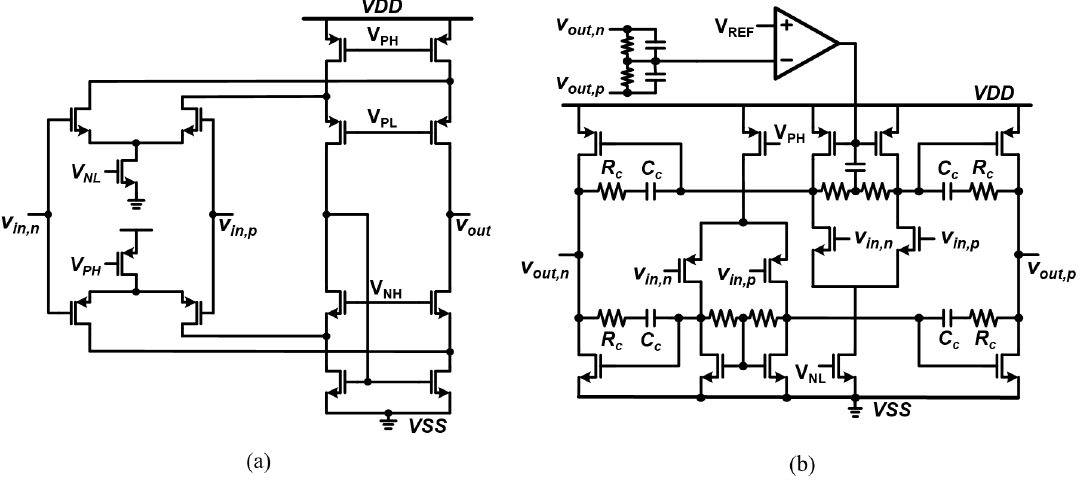
Figure 7. Circuit schematic of ( a ) the first-stage amplifier and ( b ) the second-stage amplifier.